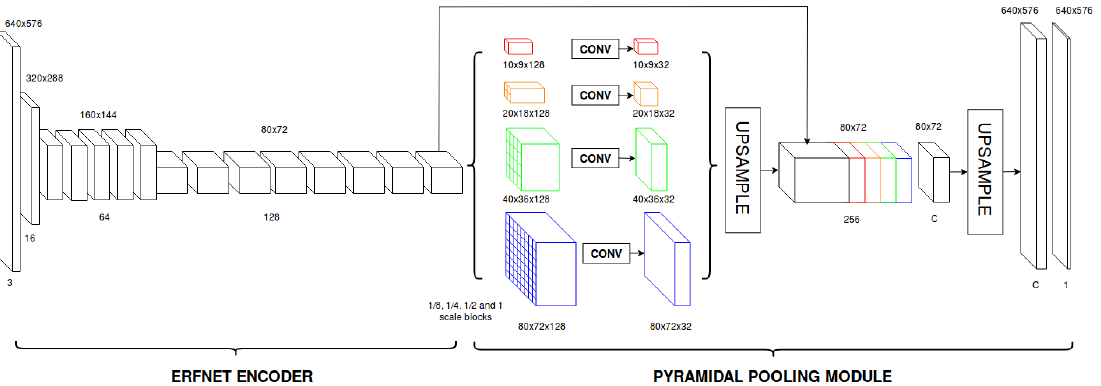
Figure 5. Diagram that depicts the proposed segmentation CNN (ERFNetPSP). Volumes correspond to the feature maps produced by each layer for an example input of 640 × 576. Table 1. Layer disposal of our proposed